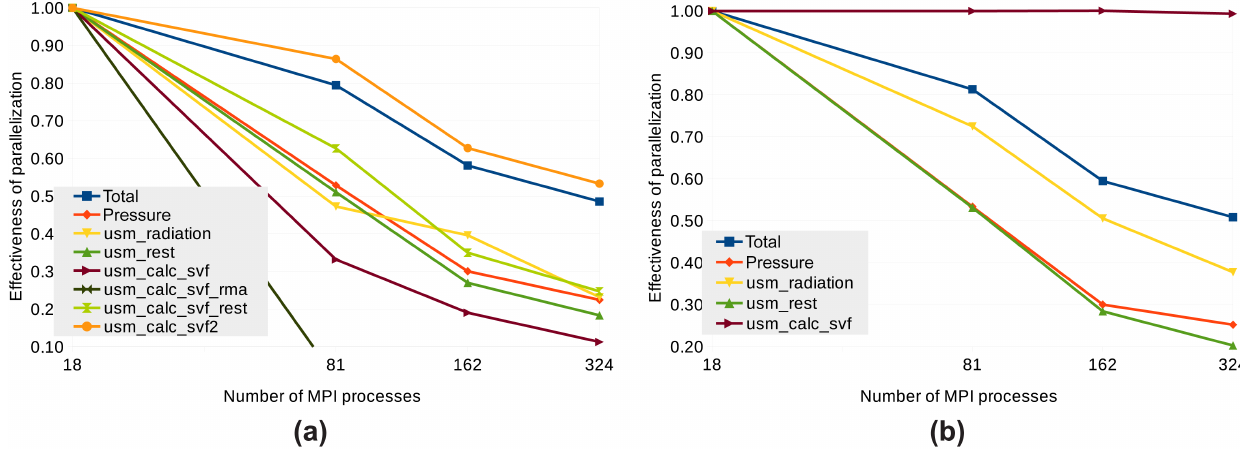
Figure 22. Effectiveness of the parallelization of the chosen subroutines: (a) simulation with plant canopy, (b) without plant canopy. The meaning of the items is the same as in Fig.